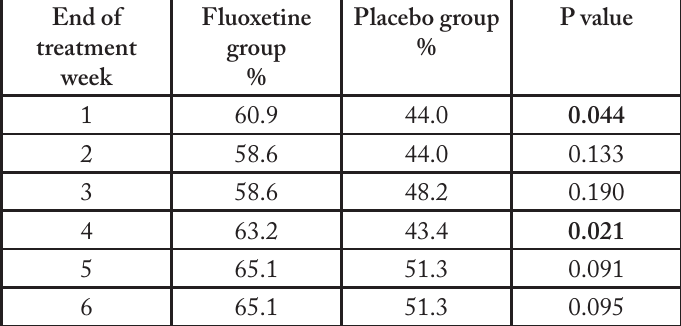
Table 1: Percentage of fluoxetine and placebo dogs with improved global separation anxiety scores. Significant P value also reported from using a generalised linear mixed